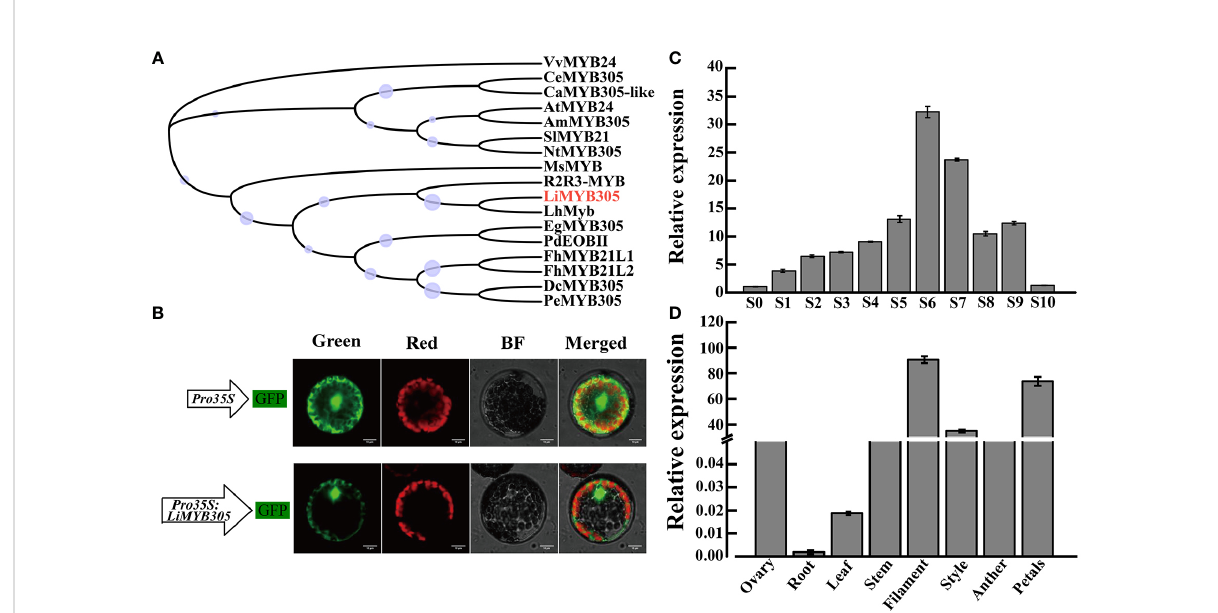
FIGURE 4 Characterization of Lilium ‘ Siberia ’ LiMYB305. (A) Phylogenetic tree of the LiMYB305 protein. LiMYB305 is marked in red. Bootstrap values are shown as a percentage of 1,000 replicates. The purple circle pattern represents the bootstrap, and the larger the circle, the larger the bootstrap. DcMYB305 (XP_020690104.1), PeMYB305 (XP_020572046.1), EgMYB305 (XP_010924268.1), PdEOBII; (XP_008800726.2), R2R3-MYB (AMO43680.1), LhMyb (BAB40790.1), AtMYB24 (AAM63674.1), VvMYB24 (NP_001268062.1), AmMYB305 (P81391.1), NtMYB305 (XP_016506729.1), SIMYB21 (NP_001351943.1), CeMYB305 (XP_027154721.1), CaMYB305-Like (XP_027073189.1), MsMYB (AQR58379.1) FhMYBL1 (QNC43969.1), and FhMYBL2 (QNC43970.1). (B) Subcellular localization of LiMYB305. Green, GFP fl uorescence detected in the green channel; Red, chlorophyll fl uorescence detected in the red channel; Merged, merged green and red channel images; BF, bright- fi eld image. Bars = 10 m m. (C) Expression pro fi les of LiMYB305 during the 11 developmental stages. (D) Expression pro fi les of LiMYB305 in eight